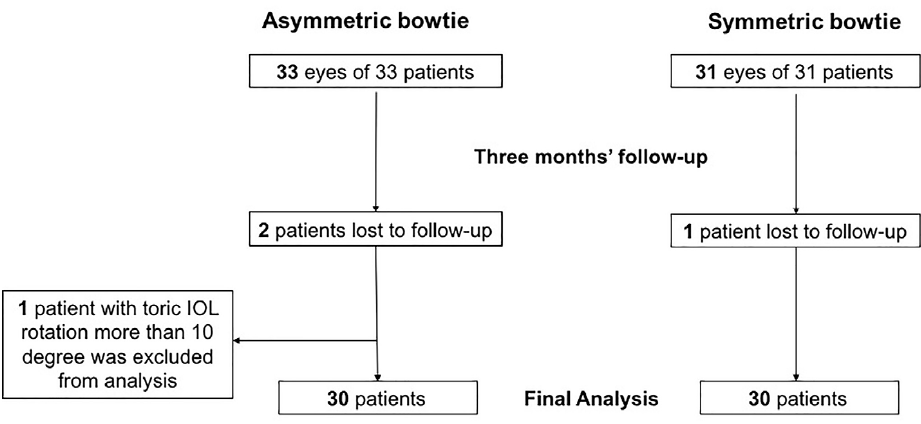
Figure 1. Patient flow chart.